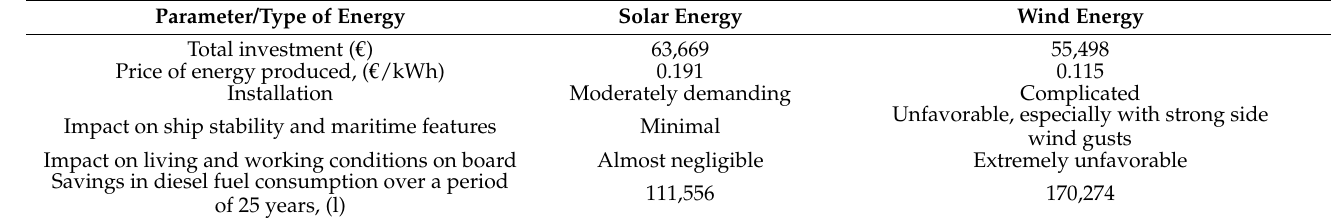
Table 8. Comparative presentation of the application of solar and wind